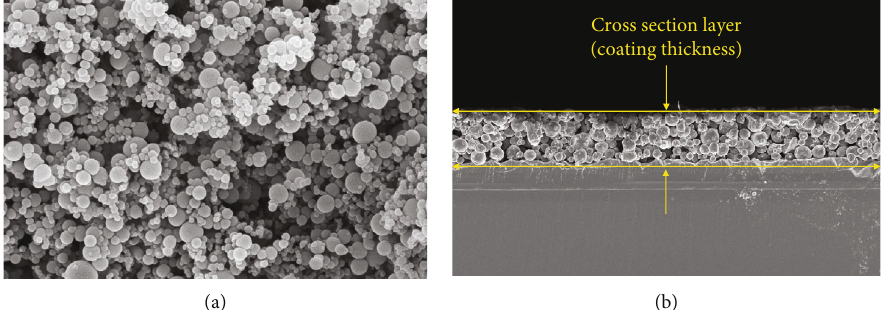
Figure 10: (a) Surface morphology of the A-IV-coated solar cell. (b) Cross-sectional view of the A-IV-coated solar cell.